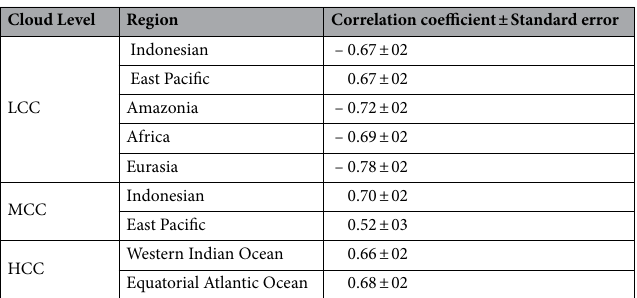
Table 1. The correlation coefficient between ideal band-pass filtered and the GCR domains which exhibited significant patterns in the composite